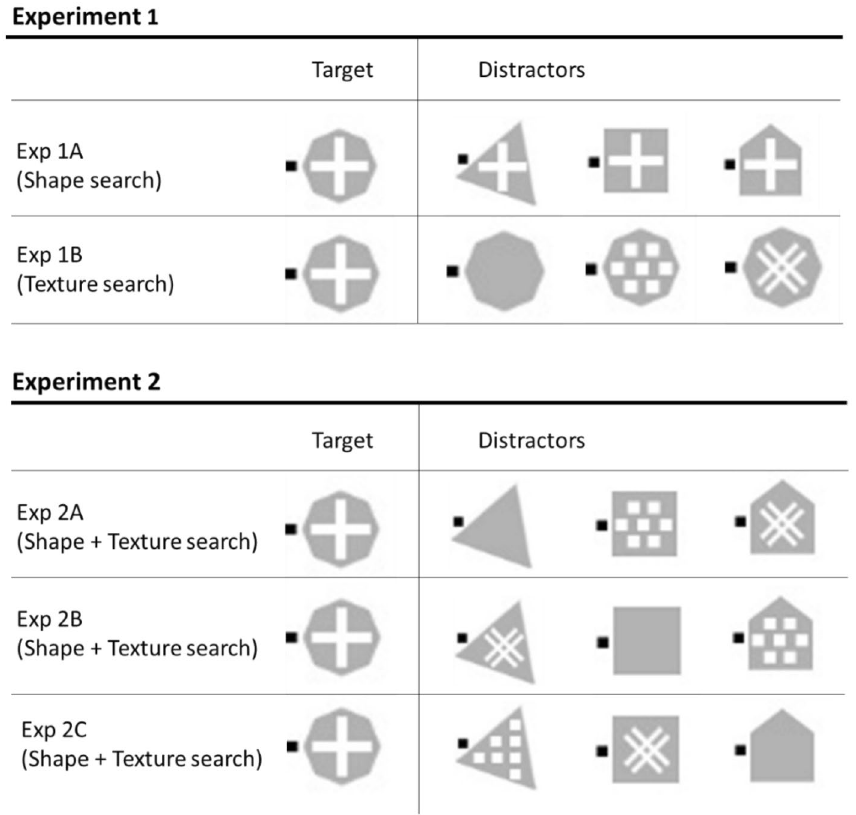
Figure 3. Stimuli used in Experiments 1 and 2. The black squares near stimuli were presented either on the left or right of the stimulus. Participants were asked to report the left or right location of the black square of the target item. A group of naïve participants completed each